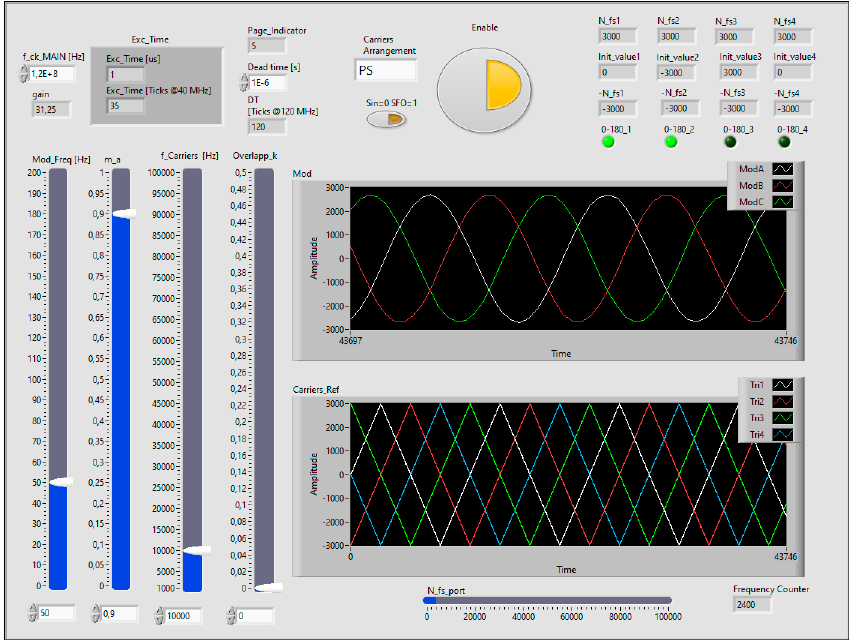
Figure 8. Front panel user interface in the case of phase-shifted as the carriers pattern and sinusoidal waveforms as modulation signals.